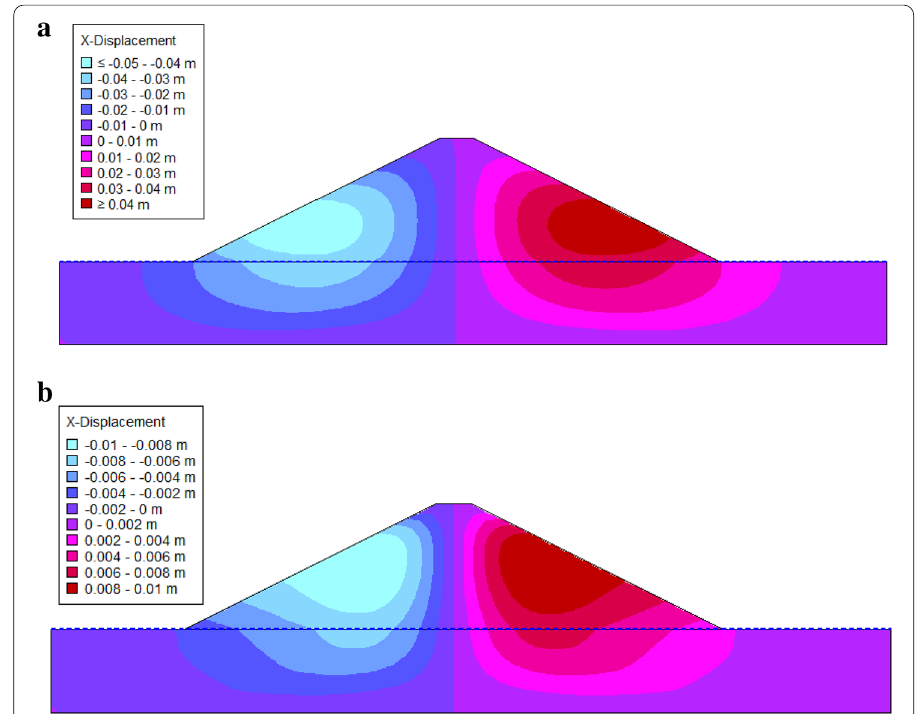
Fig. 8 Variation of horizontal displacements along the faces of the homogeneous earthen dam a Single lift, b Sequential multiple